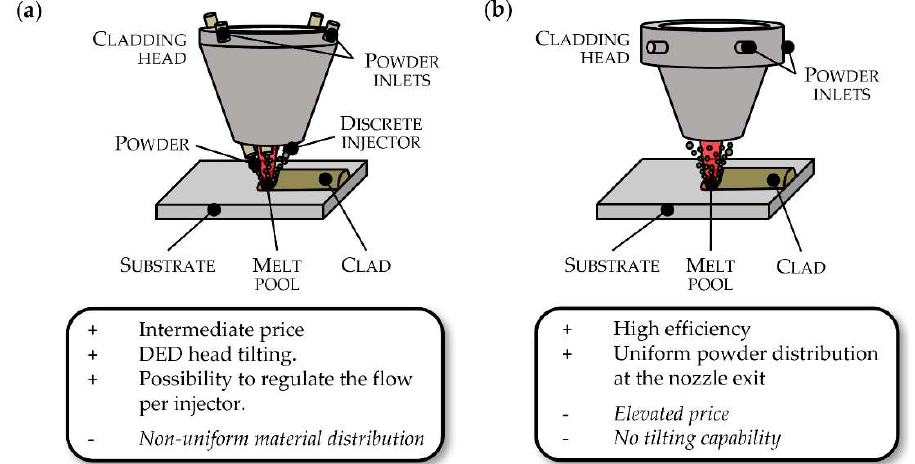
Figure 5. Different nozzles used in powder-based DED: ( a ) Discrete and ( b ) Continuous coaxial nozzles. Reproduced with permission from [76], Elsevier, 2017.